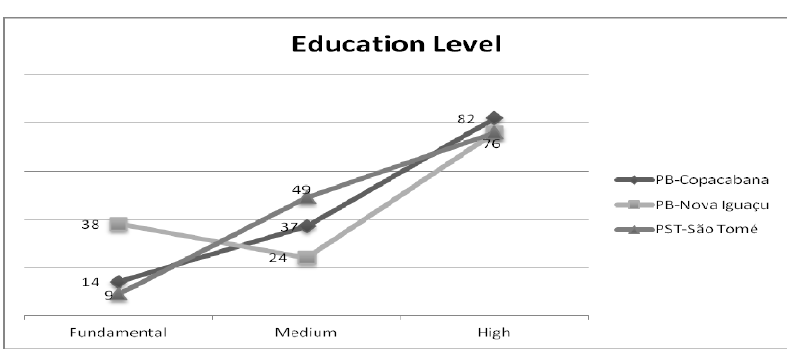
Figure 3. Actuation of education level for implementing the number mark within the NP in BP (Copacabana and Nova Iguaçu) and also in STP in